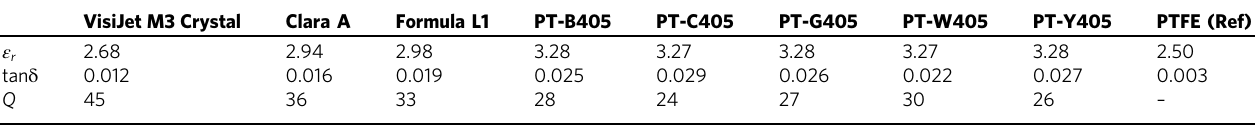
Unloaded quality factors of LM SAP probehead were also measured with these different